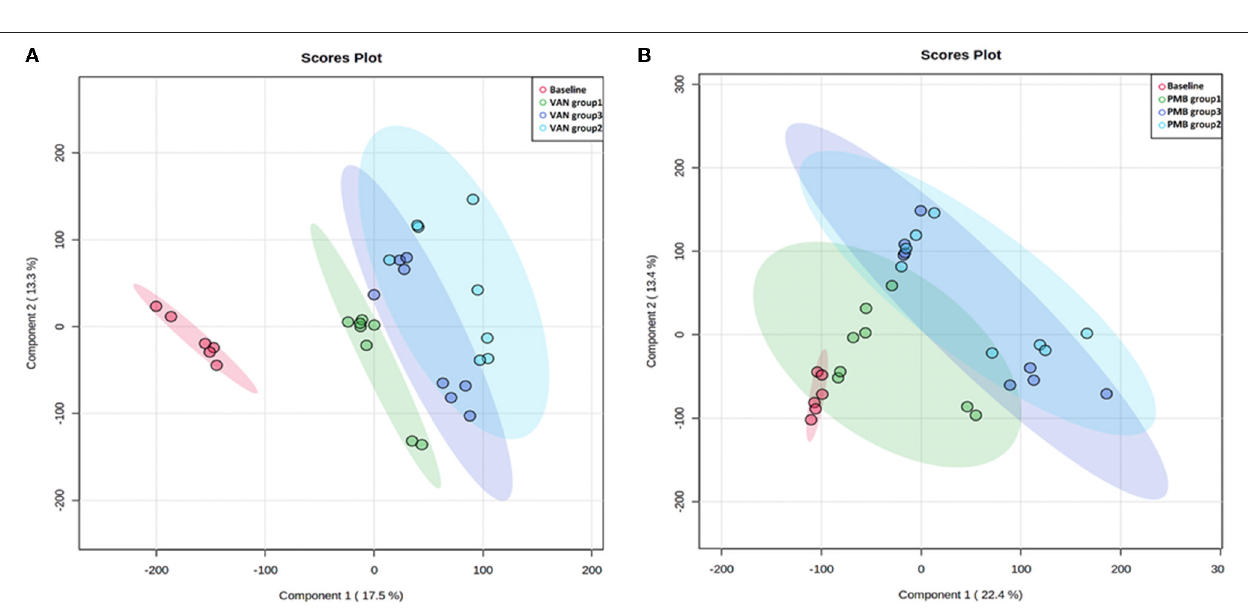
FIGURE 6 | Polymyxin B induced change in alpha diversity. Observed species, Chao 1, ACE, Shannon, Simpson, and PD whole tree indexes were shown in (A–F) , respectively. Significant differences between the two groups were marked, and * p < 0.05; ** p < 0.01, and *** p < 0.001. PMB, polymyxin B.